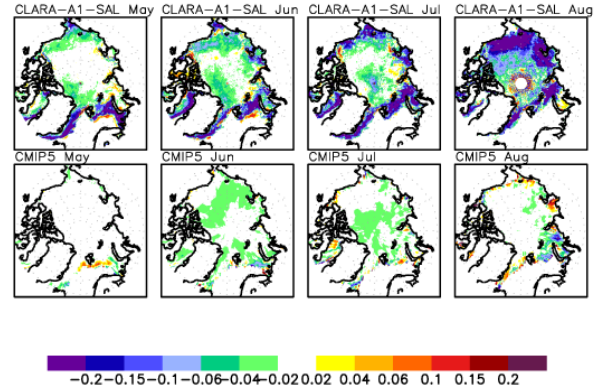
Fig. 7. Sea ice albedo trend for May, June, July and August in CLARA-SAL and the CMIP5 ensemble mean. Shown is the trend per 24yr (1982–2005).